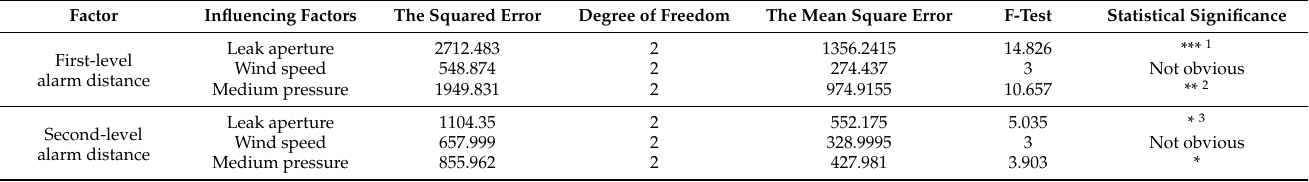
Table 2. Analysis of variance